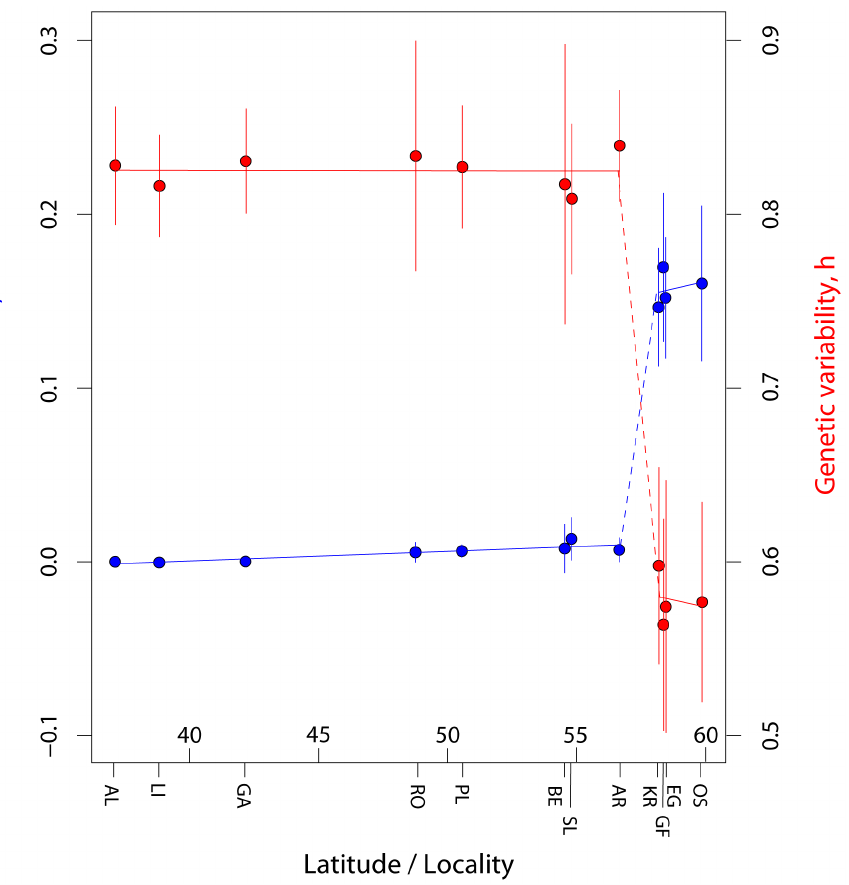
Figure 3. The figure illustrate the cline of F ST (blue) and expected heterozygosity (red) with latitude. Lines connecting points are linear regression lines, calculated separately for the southern and northern (Scandinavian) parts, with dotted lines indicating the "genetic break" across the North Sea. The 95% confidence intervals are indicated with vertical bars for each point estimate, calculated as: mean + / 2 1.96*SE (i.e., assuming normal distribution). For F ST standard errors were calculated by jackknifing over loci,; for heterozygosity (h), standard errors were taken as the square root of the intralocus variances, averaged over loci (equations 8.12 and 8.14 of ref. [63]).